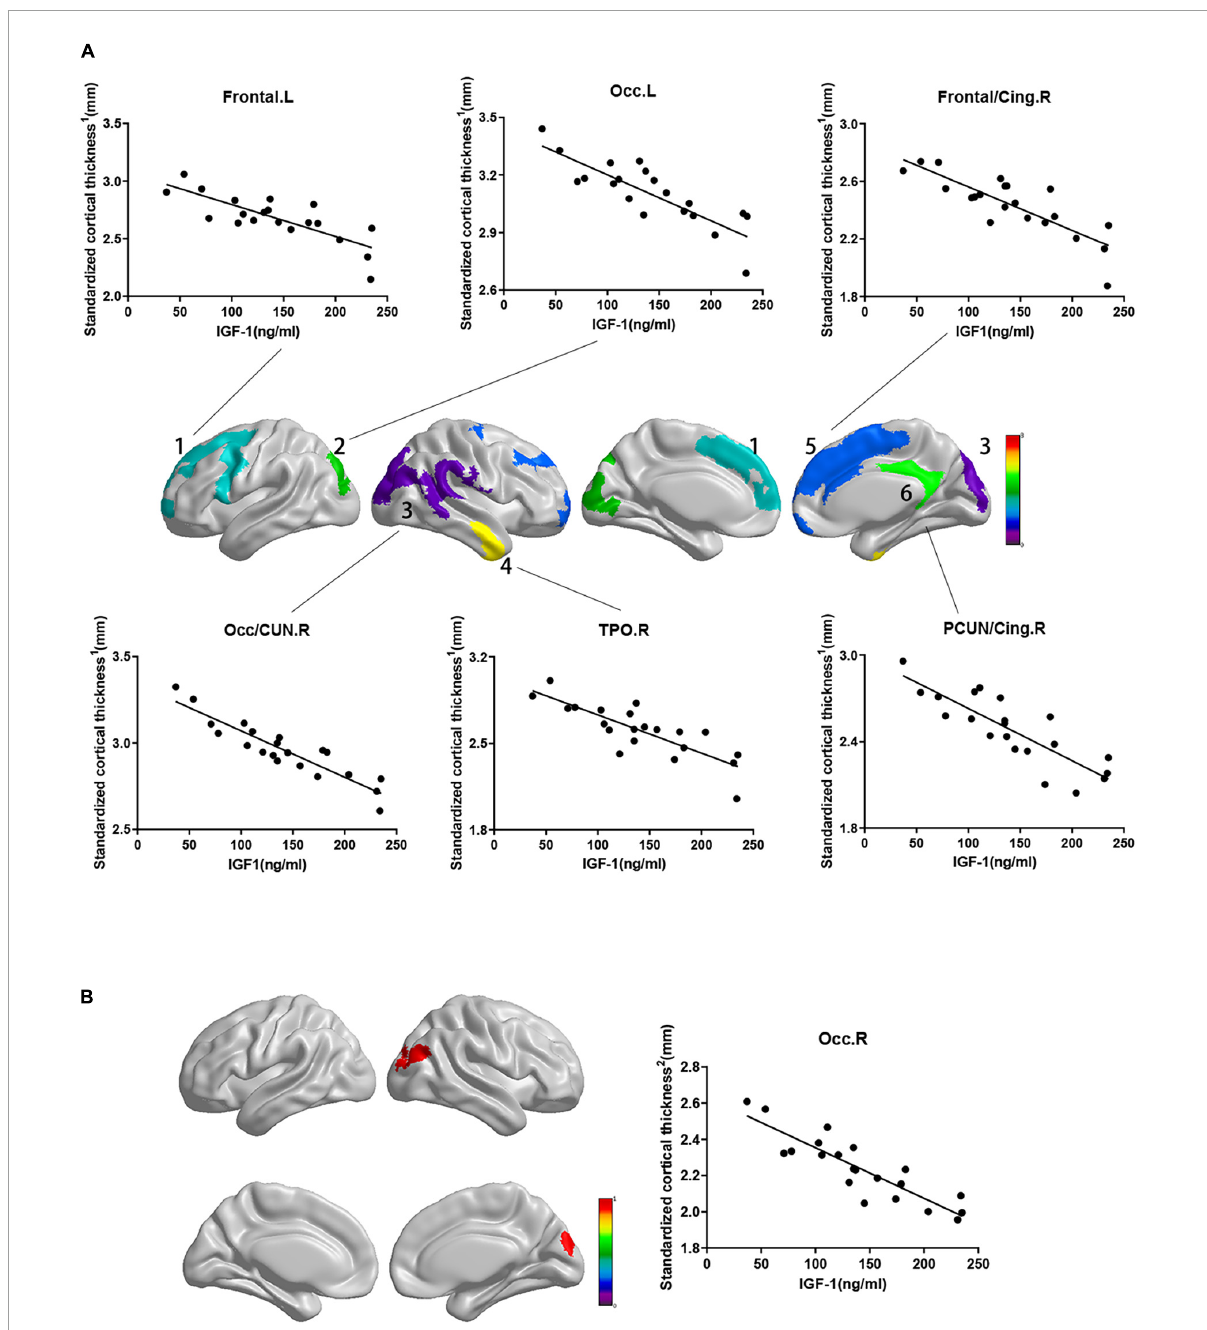
FIGURE2 Correlations between standardized cortical thickness and serum IGF-1 levels in specific regions. Standardized cortical thickness 1 in panel (A) refers to cortical thickness standardized for the whole brain volume (absolute cortical thickness divided by the whole brain volume). Standardized cortical thickness 2 in panel (B) refers to cortical thickness standardized for average cortical thickness (absolute cortical thickness divided by average cortical thickness for the whole brain). Regions with P < 0.05 are shown. (A) Cortical thickness standardized for brain volume of above regions were negatively correlated with serum IGF-1 levels after adjusted for age, gender and group. (a) frontal.L: r = –0.693, P = 0.001; (b) Occ.L: r = –0.743, P < 0.001; (c) frontal/cing.R: r = –0.708, P < 0.001; (d) Occ/CUN.R: r = –0.870, P < 0.001; (e) TPO.R: r = –0.718, P = 0.001; (f) PCUN/Cing.R: r = –0.709, P = 0.001. (B) Cortical thickness standardized for average cortical thickness of Occ.R were negatively correlated with serum IGF-1 levels ( r = –0.761, P < 0.001) after adjusted for age, gender and group. IGF-1, insulin-like